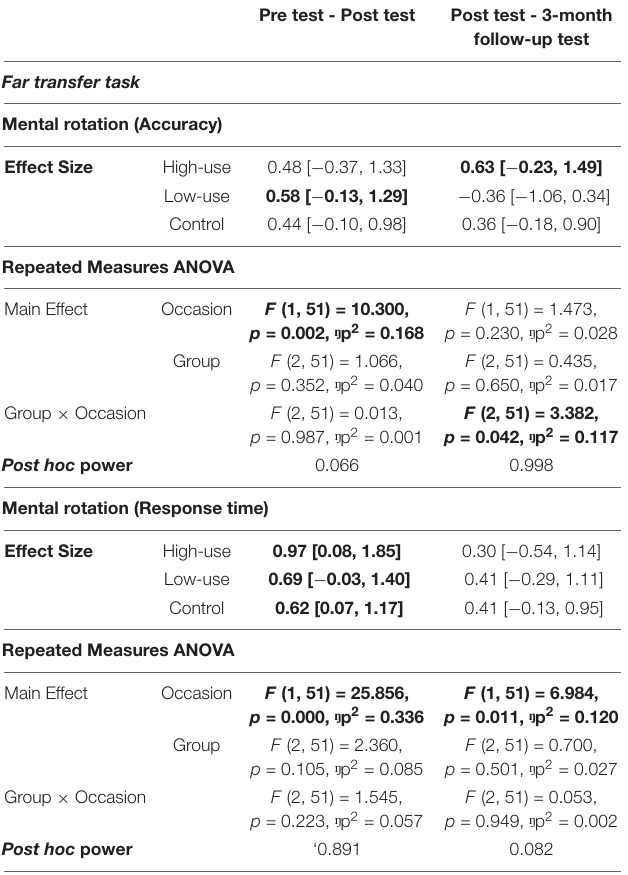
TABLE 13 | ANOVA analysis and effect sizes of far transfer mental rotation task in Experiment 2.